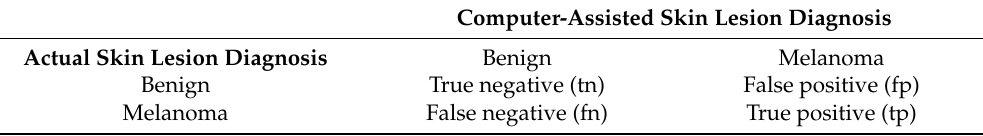
Table 1. Skin lesion diagnosis categorization based on the type of skin